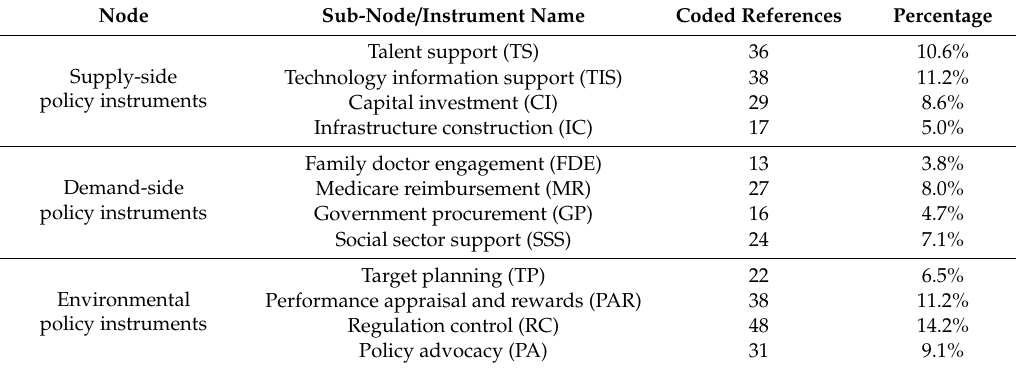
Table 2. Coded references statistics.